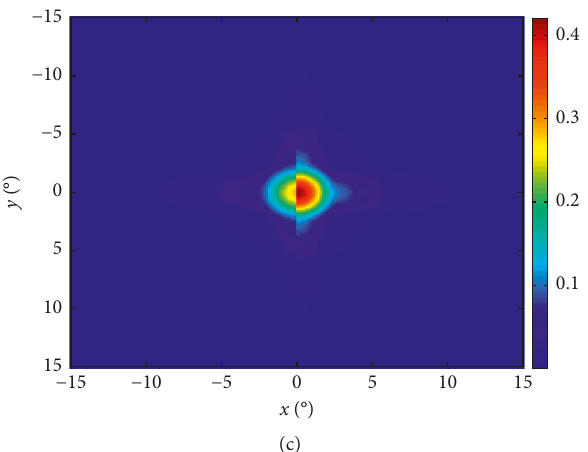
� σ R � 3m). (a) Primary frequency; (b) 0 0 0